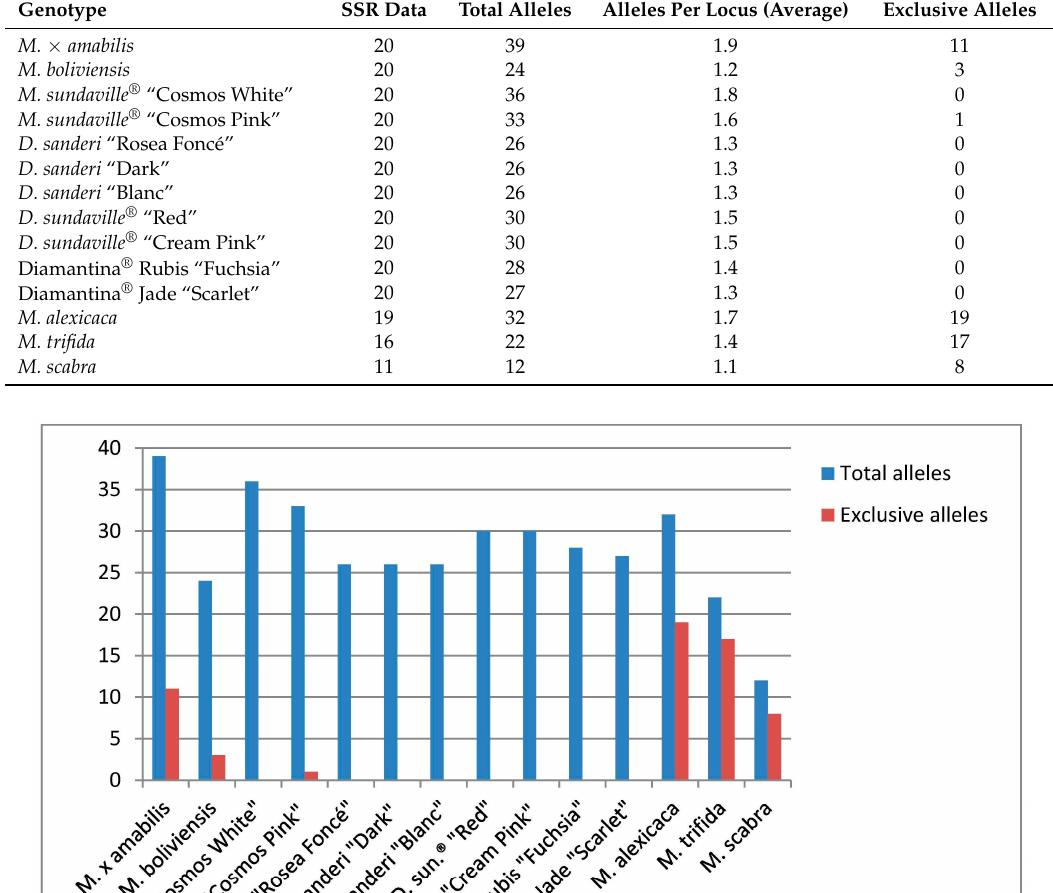
Table 2. Total and exclusive alleles detected in 14 Mandevilla genotypes with 20 SSR loci.